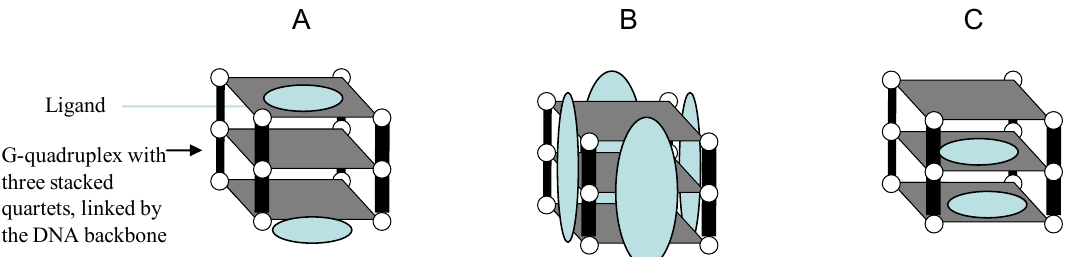
Figure 1. Interaction modes between G-Quadruplex structures and